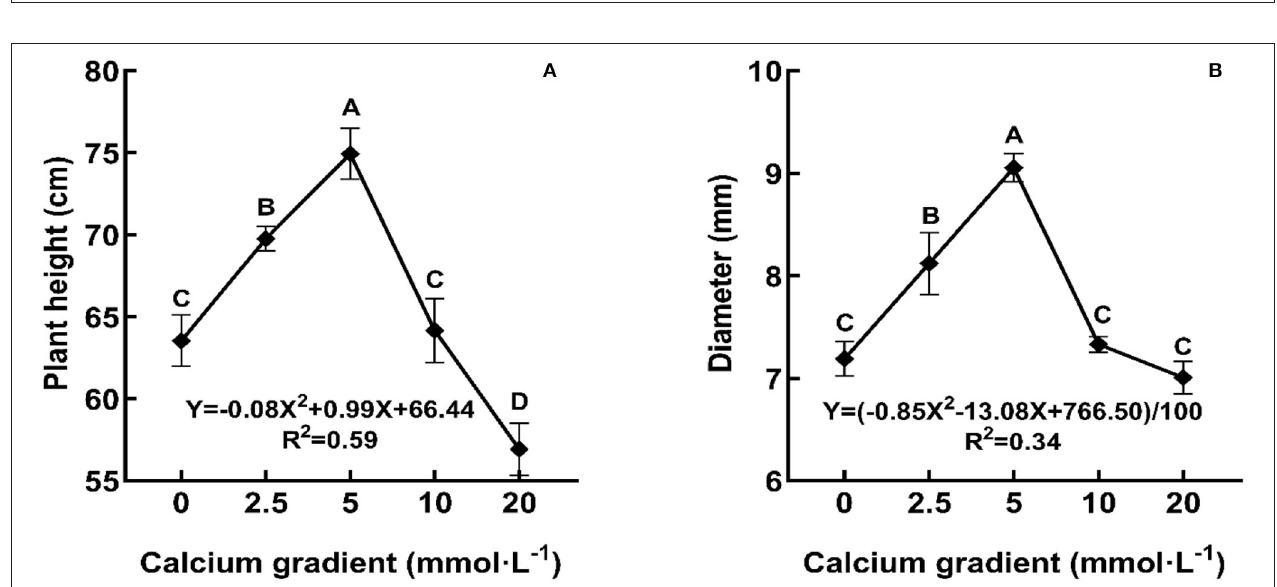
FIGURE 2 | Growth of poplar seedlings in different treatments. Each column represented the mean ± SE values, n = 3; different capital letters indicate significant differences between treatments of calcium addition ( P < 0.05).